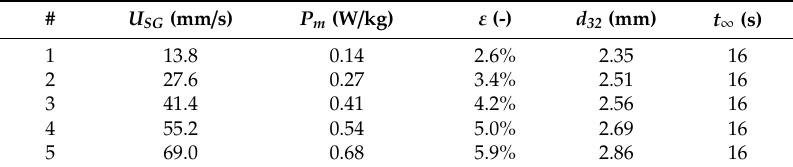
Table 1. Test matrix for the static bubble column configuration.